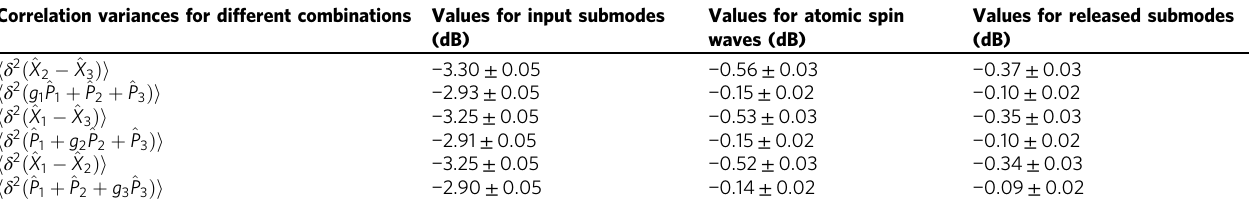
Table 1 The values of normalized correlation variances for different combinations Correlation variances for different combinations Values for input submodes